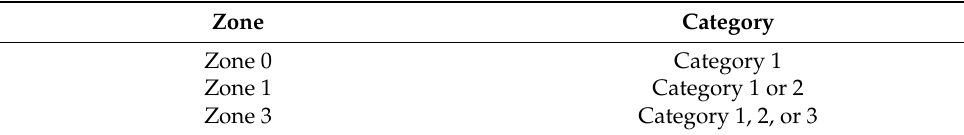
Table 3. Use of Group II of equipment in Hazardous Zones depending on its